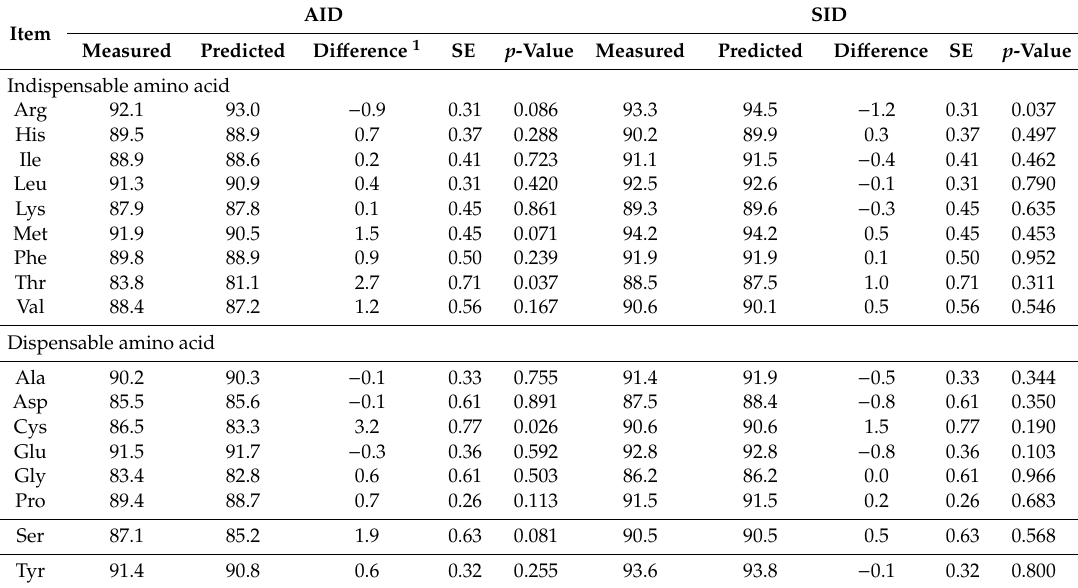
Table 9. Measured and predicted values for the AID and SID (%) of AAs and di ff erence between measured and predicted AID and SID of AAs in male broilers fed a corn, SBM, and CCDGS mixed diet.